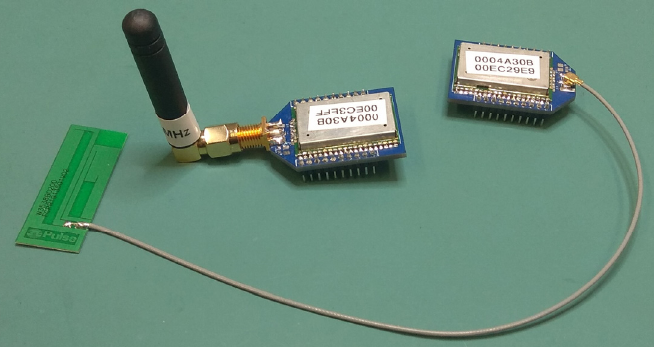
Figure 7. LoRaWAN RN2483A communication modules: one with an adhesive PCB antenna and the other with a stub helical coil.